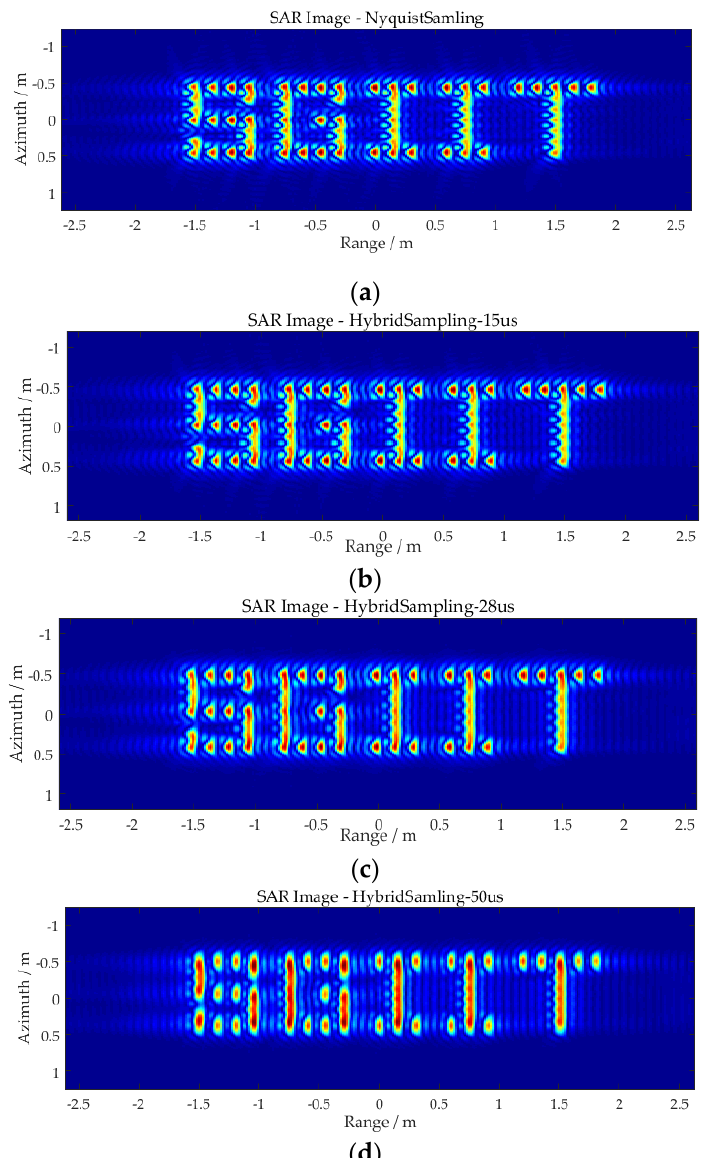
Figure 7. The SAR simulated results of point array targets with different Q factors: ( a ) Nyquist real-time sampling; ( b ) Q = 2, t hs = 15 us; ( c ) Q = 6/5, t hs = 28 us; ( d ) Q = 2/3, t hs = 50 us.